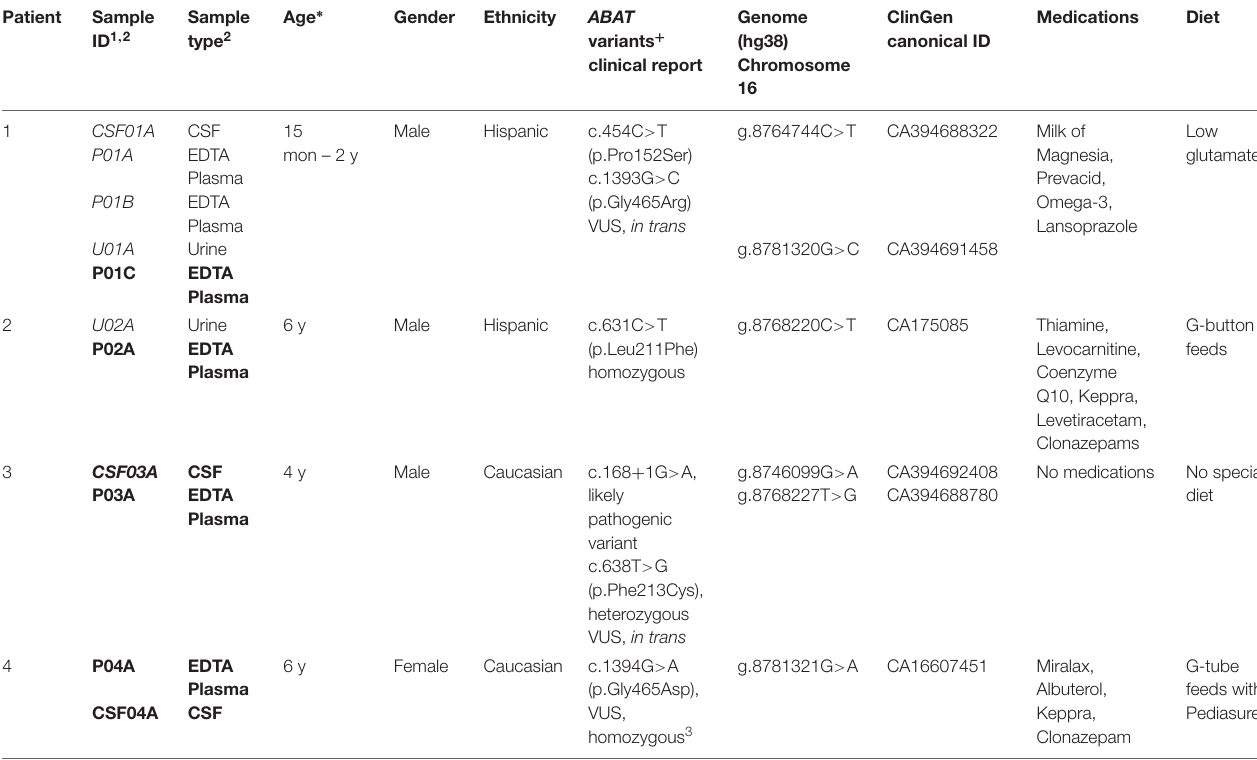
TABLE 1 | Clinical demographics of patients diagnosed with GABA-transaminase